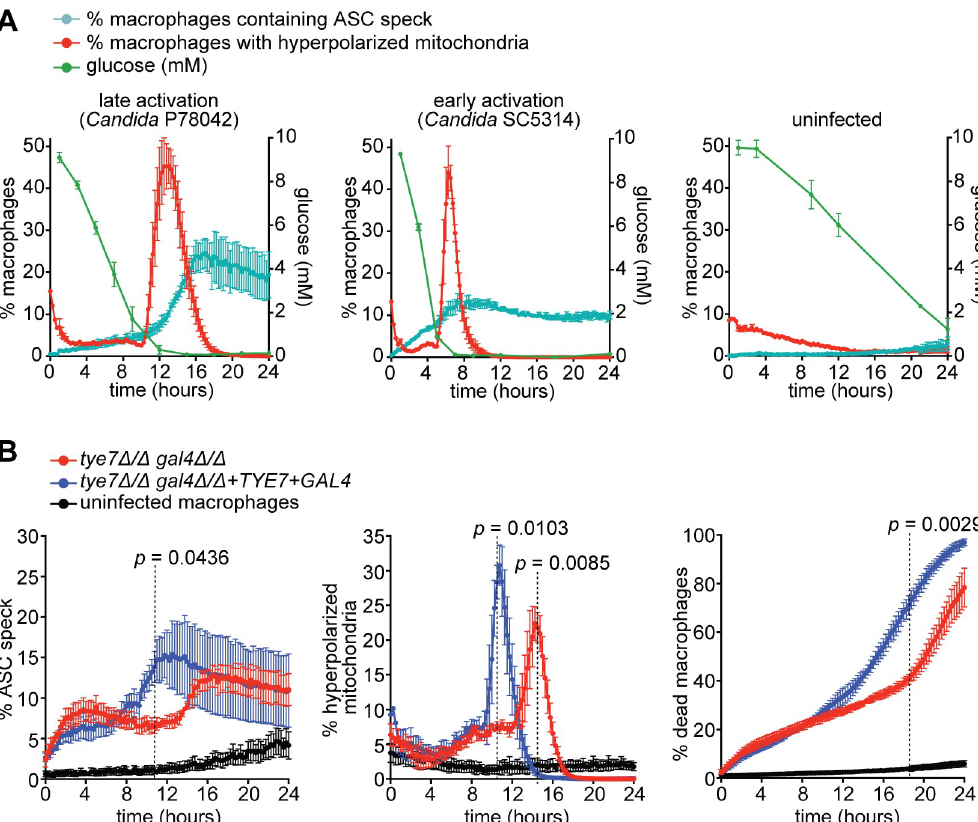
Fig 5. Activation of the inflammasome is triggered by macrophage glucose starvation. (A) ASC-mCerulean-expressing immortalized macrophages following challenge with Candida strains P78042 at MOI 6:1 (to assay late activation), SC5314 at MOI 6:1 (to assay early activation), or left uninfected. Plotted on the left axes are % macrophages containing an ASC speck and % macrophages with hyperpolarized mitochondria as quantified in live cell imaging experiments (in cyan and red respectively). Plotted on the right axes are glucose concentration measurements at select time points (in green). Data are the mean values and SEM from 2 independent experiments, and in live cell imaging this involved at least 6000 macrophages surveyed for each condition, per experiment. (B) Comparison of the C . albicans glycolytic mutant tye7 Δ / Δ gal4 Δ / Δ versus the TYE7 GAL4 complemented strain in ASC-mCerulean-expressing immortalized macrophages, along with uninfected macrophages (“macrophages only” control). The MOI was 1:1 and starting tissue culture media contained 10 mM glucose. Displayed in each graph are % macrophages containing an ASC speck, % macrophages with hyperpolarized mitochondria and % dead macrophages as quantified in live cell imaging experiments. Data are the mean values and SEM from 3 independent experiments involving at least 10000 macrophages surveyed for each condition, per experiment. p values were calculated at the time points indicated by dashed lines (Student’s two-tailed t